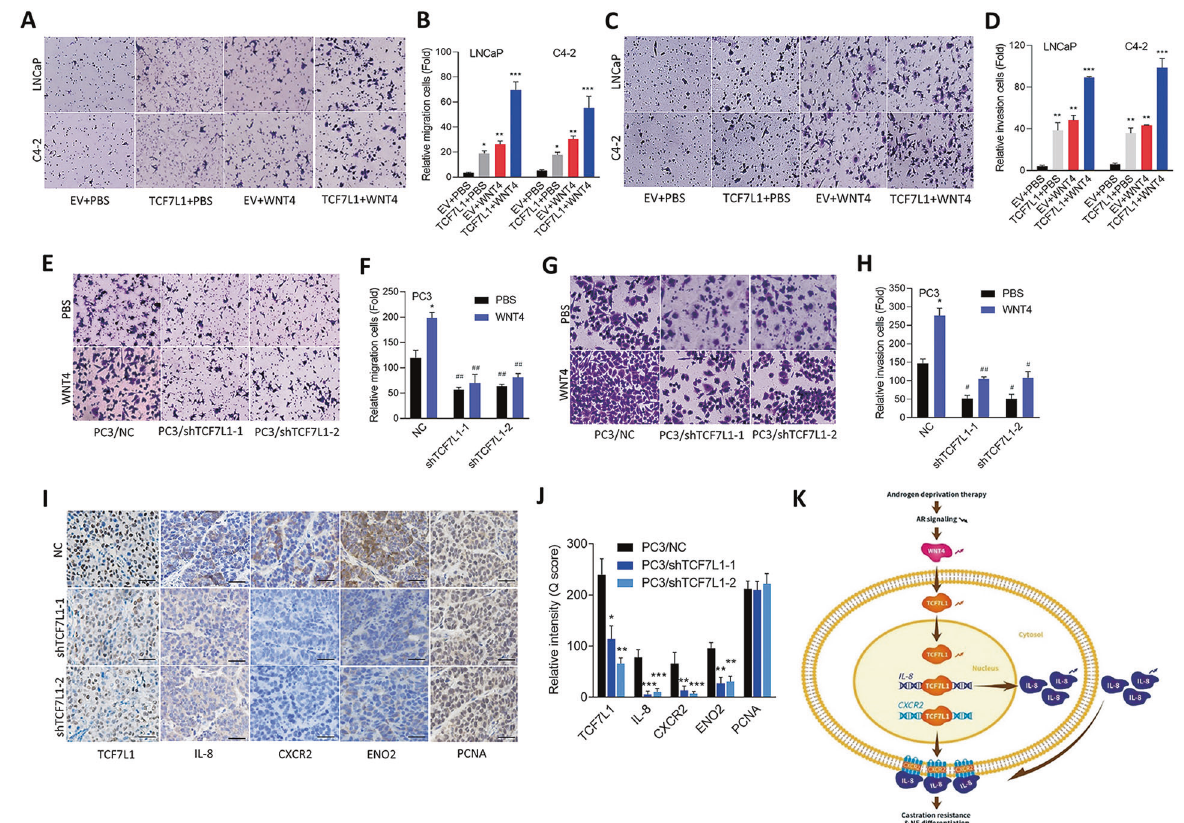
Fig. 6 WNT4/TCF7L1 upregulate cell migration and the NED of PCa cells. A – D Cell migration ( A , B ) and invasion ( C , D ) assay of LNCaP and C4-2 cells with stable overexpression of TCF7L1 or an empty vector (EV) following 100 ng/ml WNT4 treatment for 24 h. * vs. the EV + PBS. Data are presented as the mean ± SEM, n = 3. * p < 0.05, ** p < 0.01, *** p < 0.001; by a two-way ANOVA. E – H Cell migration ( E , F ) and invasion ( G , H ) assays of PC3 cells with overexpression of a nontarget control (NC) or TCF7L1 shRNA vector following 100 ng/ml WNT4 treatment for 24 h. * vs. PBS; # vs. the NC. Data are presented as the mean ± SEM, n = 3. * p < 0.05, ** p < 0.01, *** p < 0.001; by a two-way ANOVA. I , J IHC staining and analysis of subcutaneous tumors with antibodies speci fi c for TCF7L1, IL-8, CXCR2, ENO2, and PCNA in mice harboring PC3 cells expressing the NC or TCF7L1 shRNA vectors. Scale bars represent 100 µm. K Proposed model for androgen deprivation-induced WNT4/TCF7L1 signaling crosstalk with IL-8/CXCR2 signaling. ADT induced activation of the WNT4/TCF7L1 pathway, leading to upregulation of IL-8 and CXCR2. Overexpression of IL-8 and CXCR2 drives ADT resistance and NED of